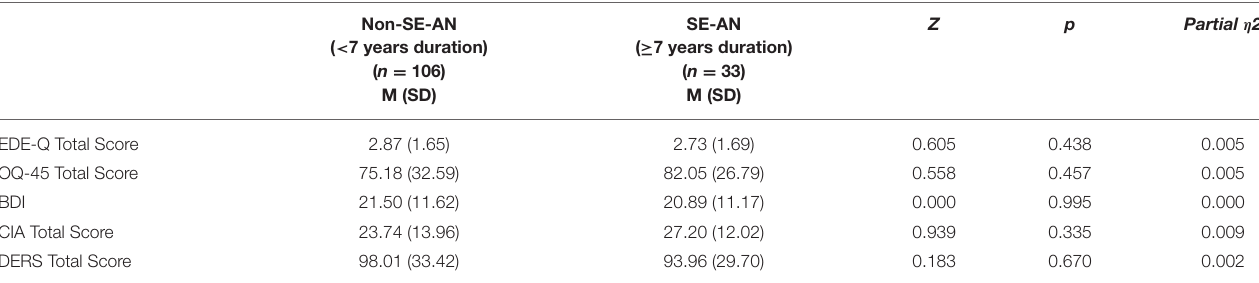
TABLE 2 | Differences between “Non-SE-AN” and SE-AN groups regarding eating attitudes and related psychopathology.